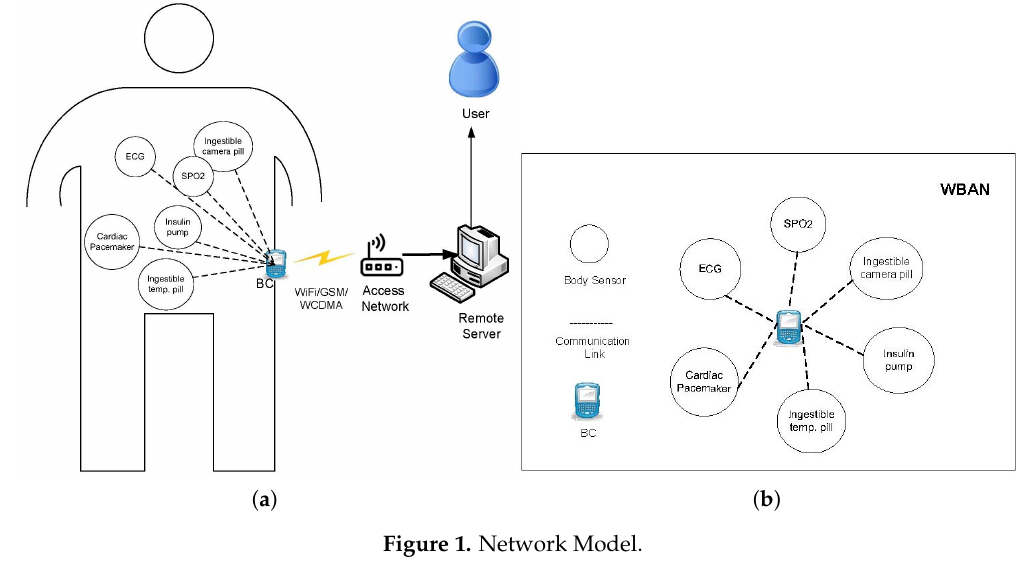
Figure 1. Network